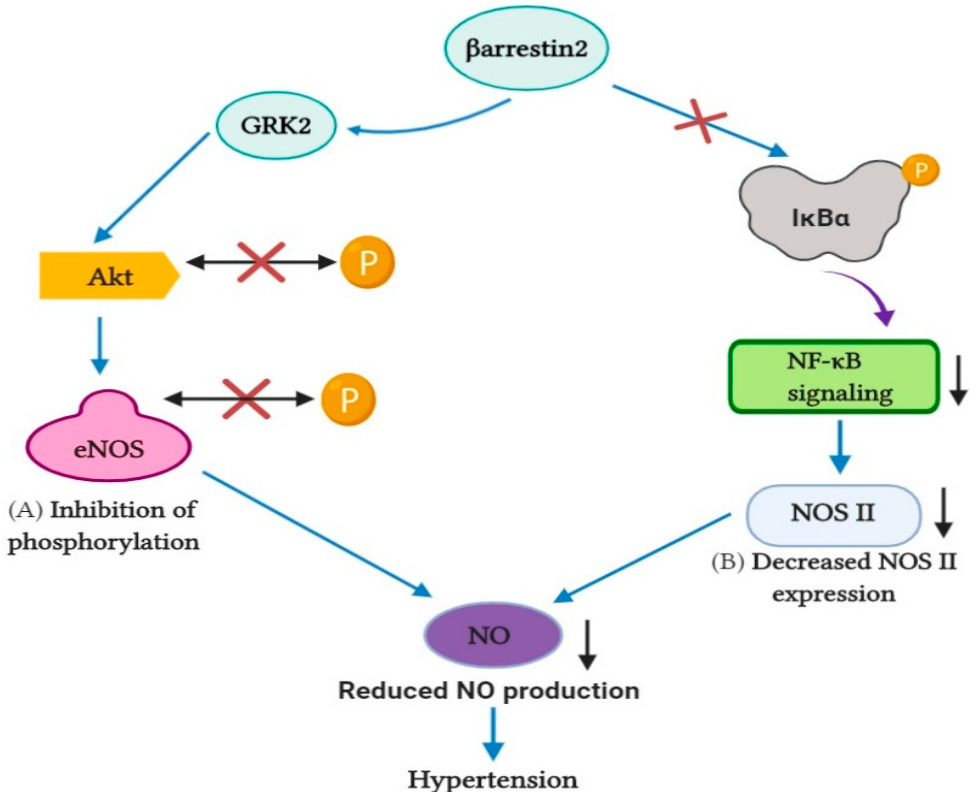
Figure 4. β -arrestin2 affects the production of NO. Along with GRK2, β -arrestin2 inhibits phosphorylation of the Akt/eNOS pathway, which decreases the amount of NO production. Furthermore, β -arrestin2 impedes NF- κ B signaling by stabilizing I κ B α , resulting in a decrease in NOS II expression and eventually decreasing the rate of NO production. Altogether, the result is increased blood